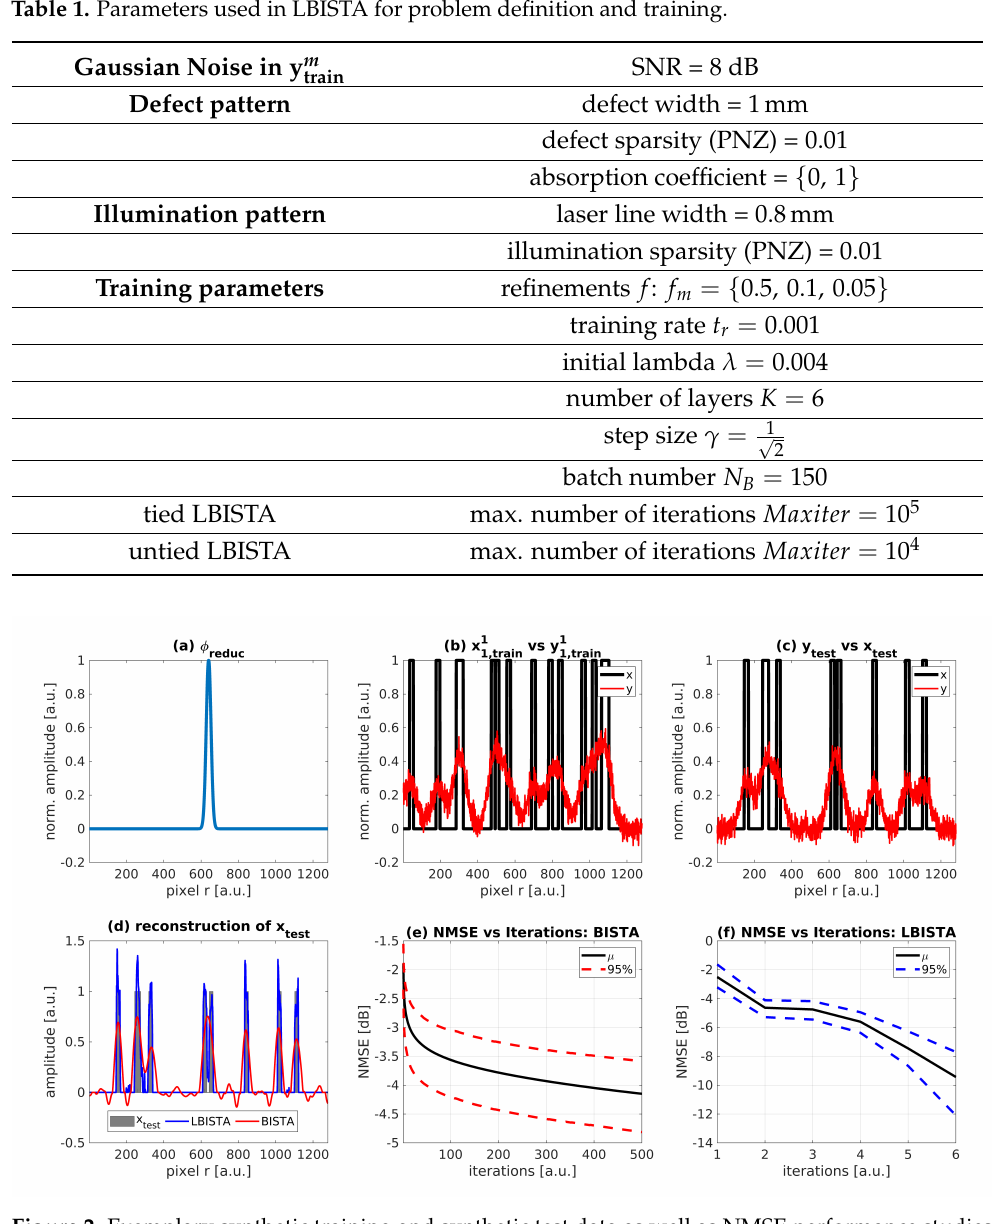
Figure 2. Exemplary synthetic training and synthetic test data as well as NMSE performance studies. ( a ): shape of used φ in training, ( b , c ): comparison of the curve shapes for exemplary training reduc ∈ R N r , ( d ): reconstruction of x test using convolution-based tied and test datasets with e.g., x 1 1,train LBISTA (6 iterations/layers) vs. BISTA (1000 iterations), ( e ): NMSE over iterations for BISTA with 95% confidence interval, ( f ): NMSE over iterations for tied LBISTA with 95% confidence